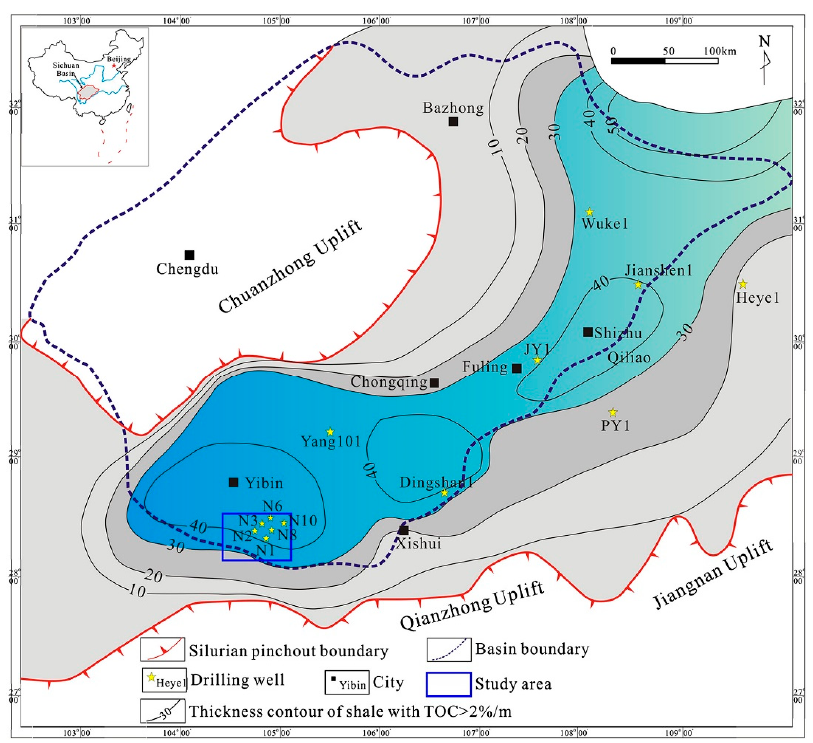
Figure 2. The location of target reservoir samples from the Longmaxi Formation used in this study (from Jiang et al., [30]).